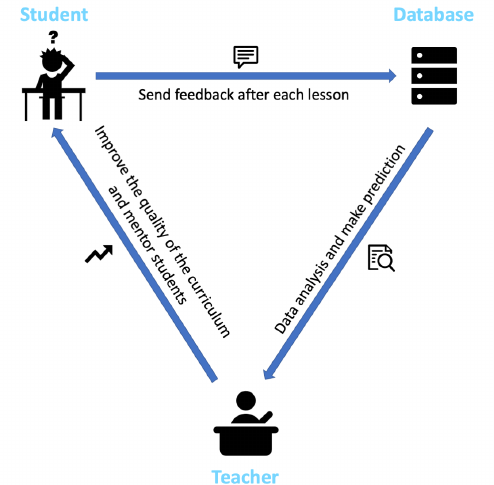
Figure 1. The conceptual graph of this